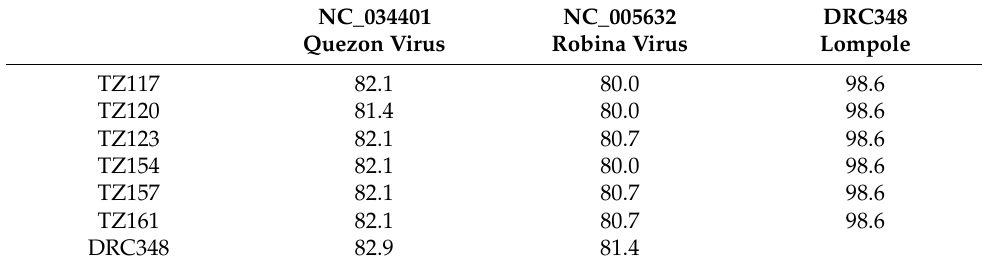
Table 2. Pairwise identities [%] between sequences from Tanzania and the Democratic Republic of Congo and their closest relatives, Quezon virus and Robina virus 1